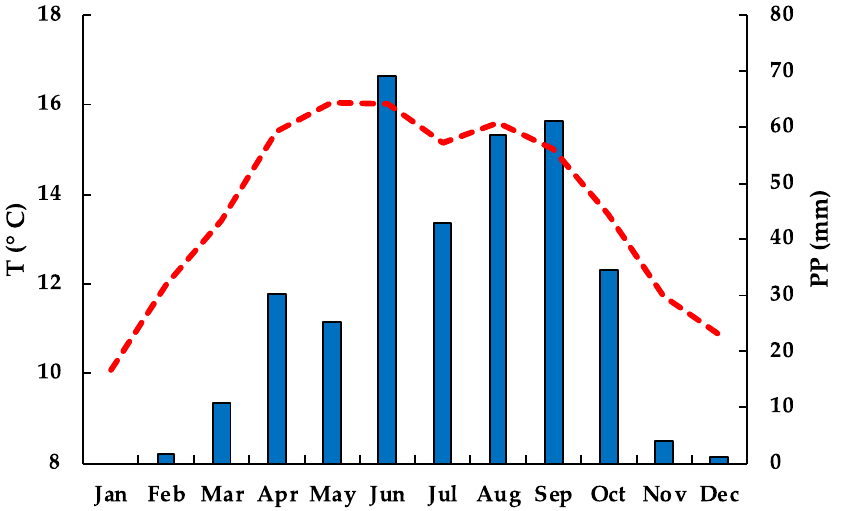
Figure 2. Station SMN-21052 climograph of normal monthly values for the 1993–2013 period. Average mean air temperature—T (red dotted curve); total rainfall—PP (blue bars).